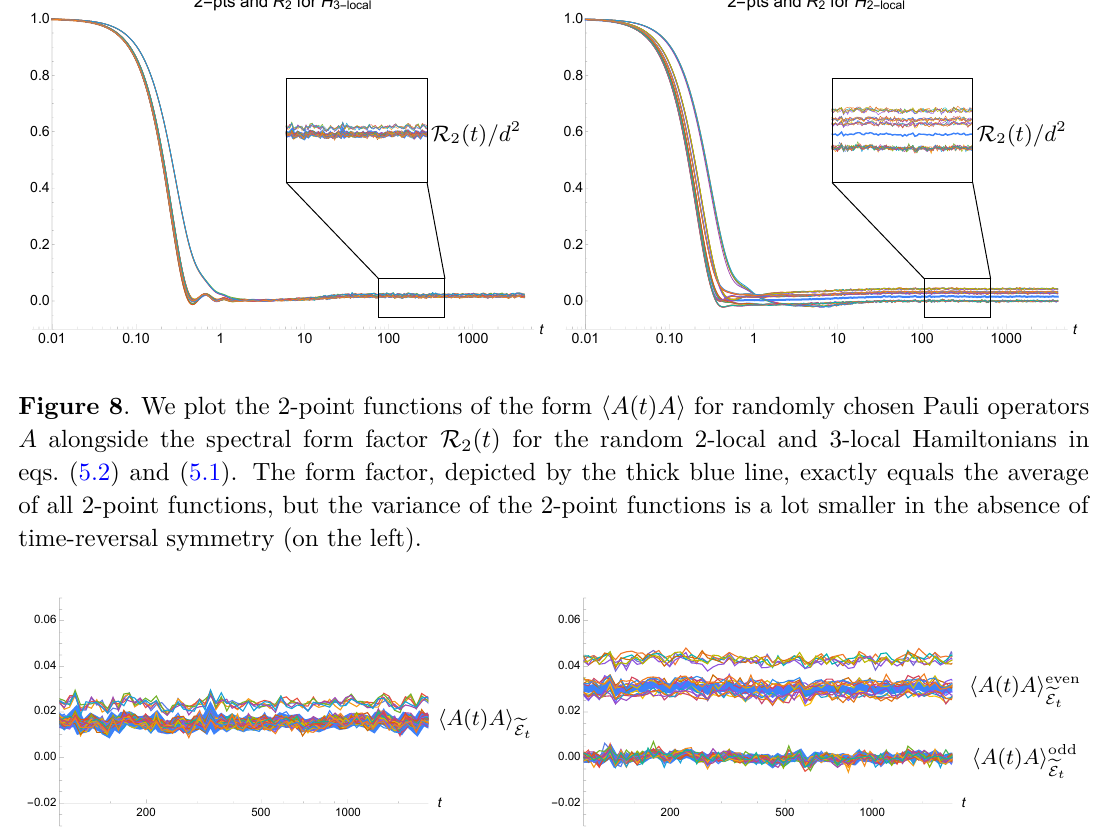
Figure 9 . We plot the late time floor of the 2-point functions h A ( t ) A i of varying weight Pauli operators on top of the invariant 2-point functions (thick blue lines) computed in terms of the spectral form factor R 2 ( t ) for the random 2-local and 3-local